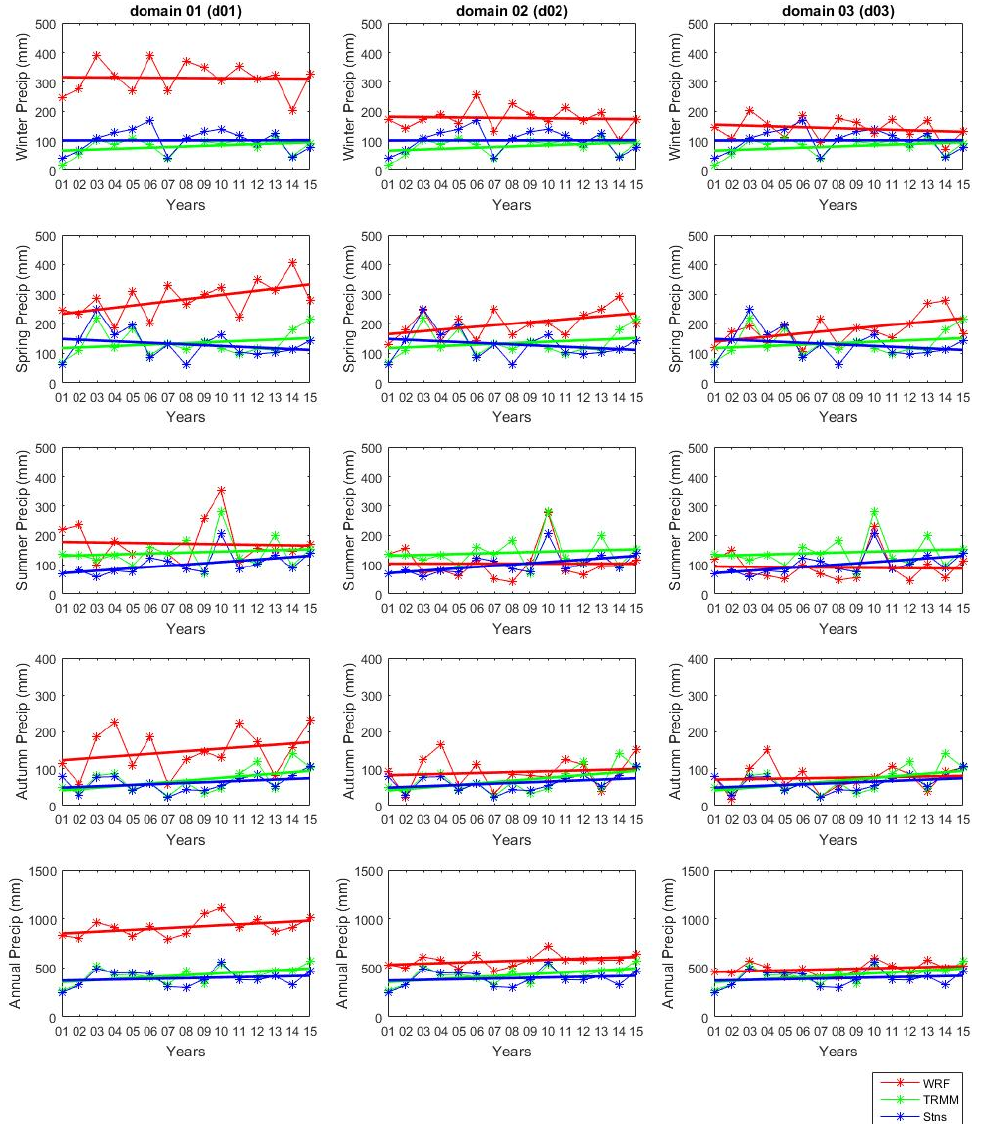
Figure 2. Time series comparisons between WRF (red), TRMM (green), and the mean of stations (“observed”; blue) for Domain 01 (d01; left column), Domain 02 (d02; middle column), and Domain 03 (d03; right column). From top to bottom, the five rows correspond to winter (DJF), spring (MAM), summer (JJA), autumn (SON), and annual. The straight lines are least ‐ squares linear regressions. When WRF and TRMM data were interpolated at the twenty ‐ three gauge locations in d02 and compared, WRF still overpredicted total annual precipitation compared with the TRMM (35%) and